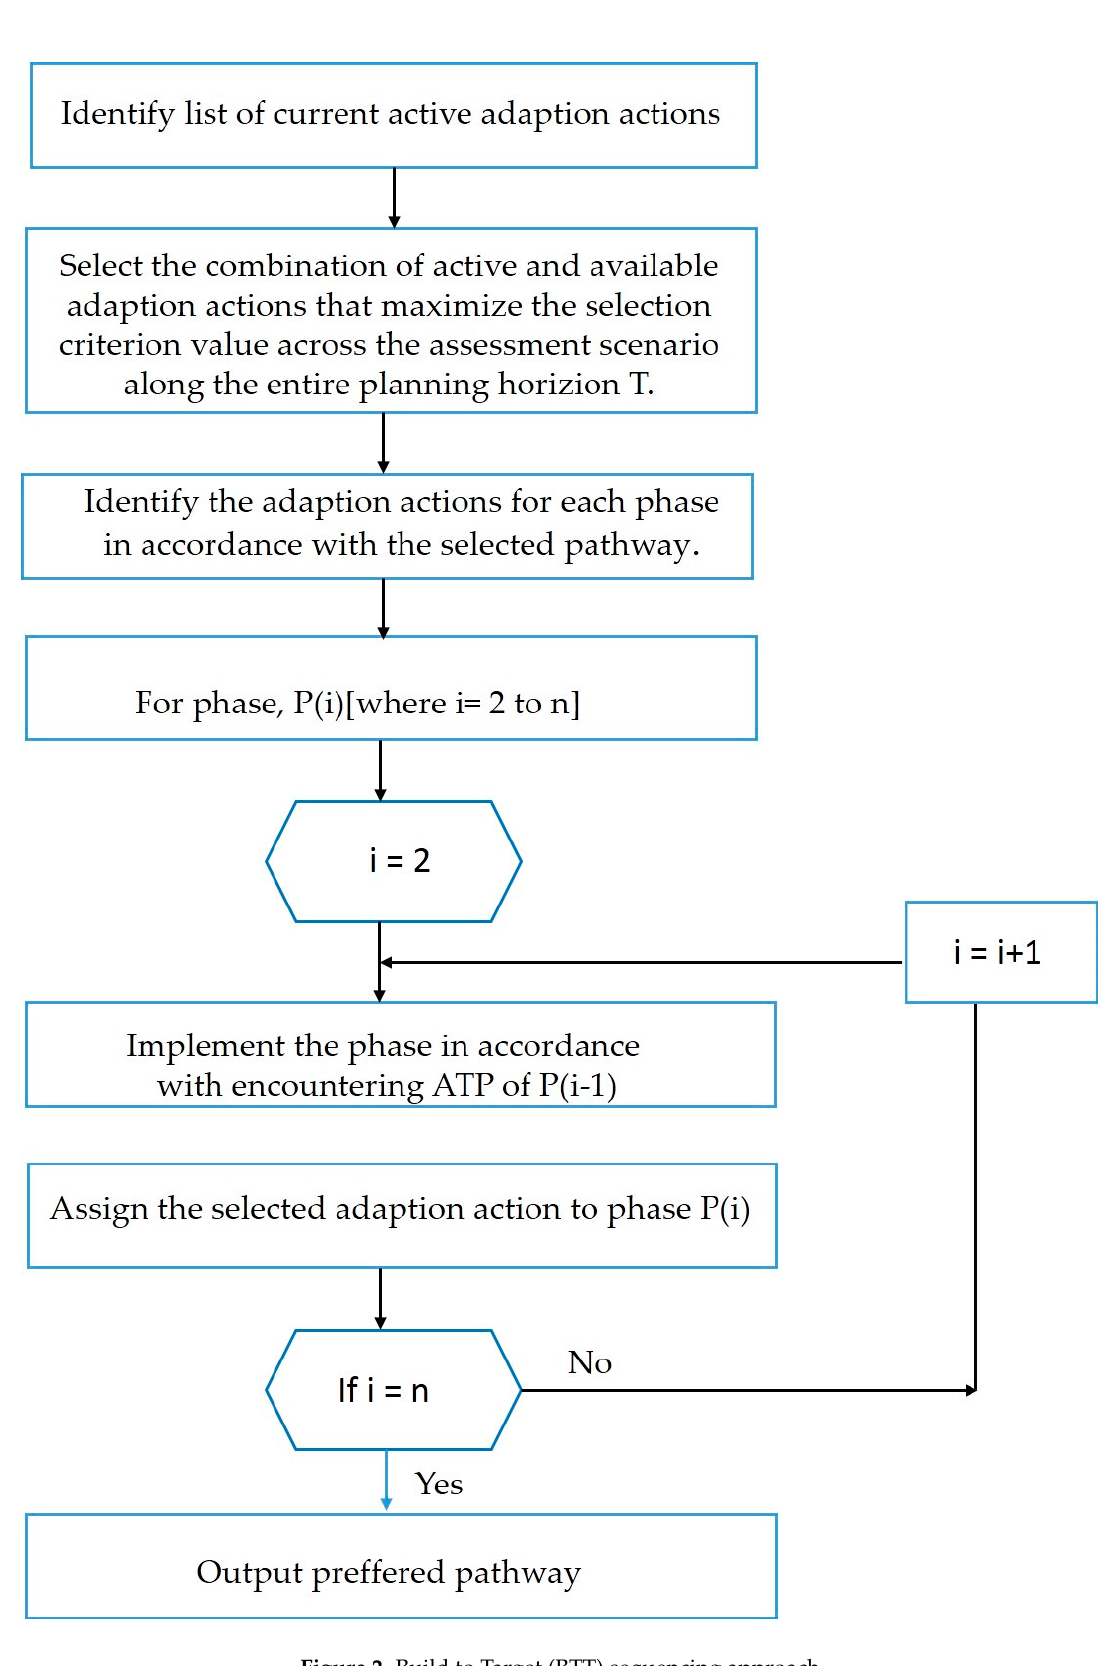
Figure 2. Build to Target (BTT) sequencing approach.